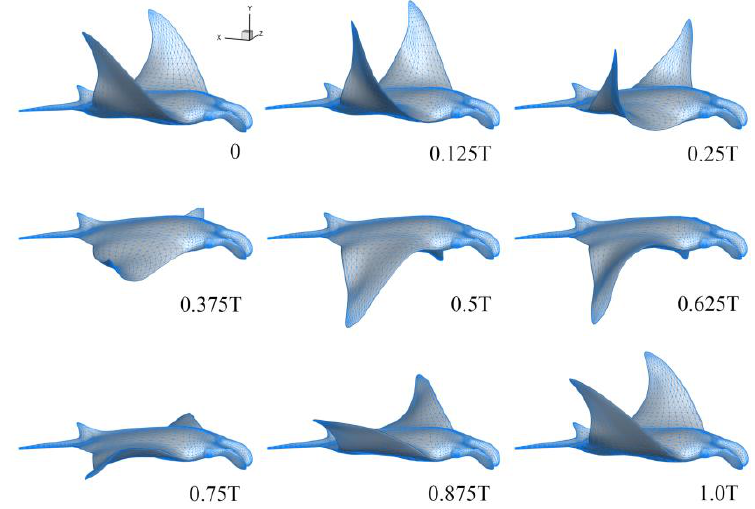
Figure 16. Sequential frames of pectoral fins’ movement of the reconstructed manta model in perspective view. The time elapsed between each frame is indicated in the bottom right corner of each frame.